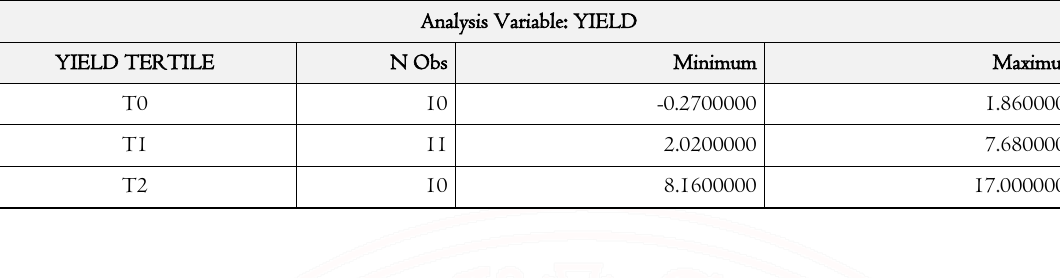
Table III. Yield Tertiles Cutoff Values Analysis Variable: YIELD